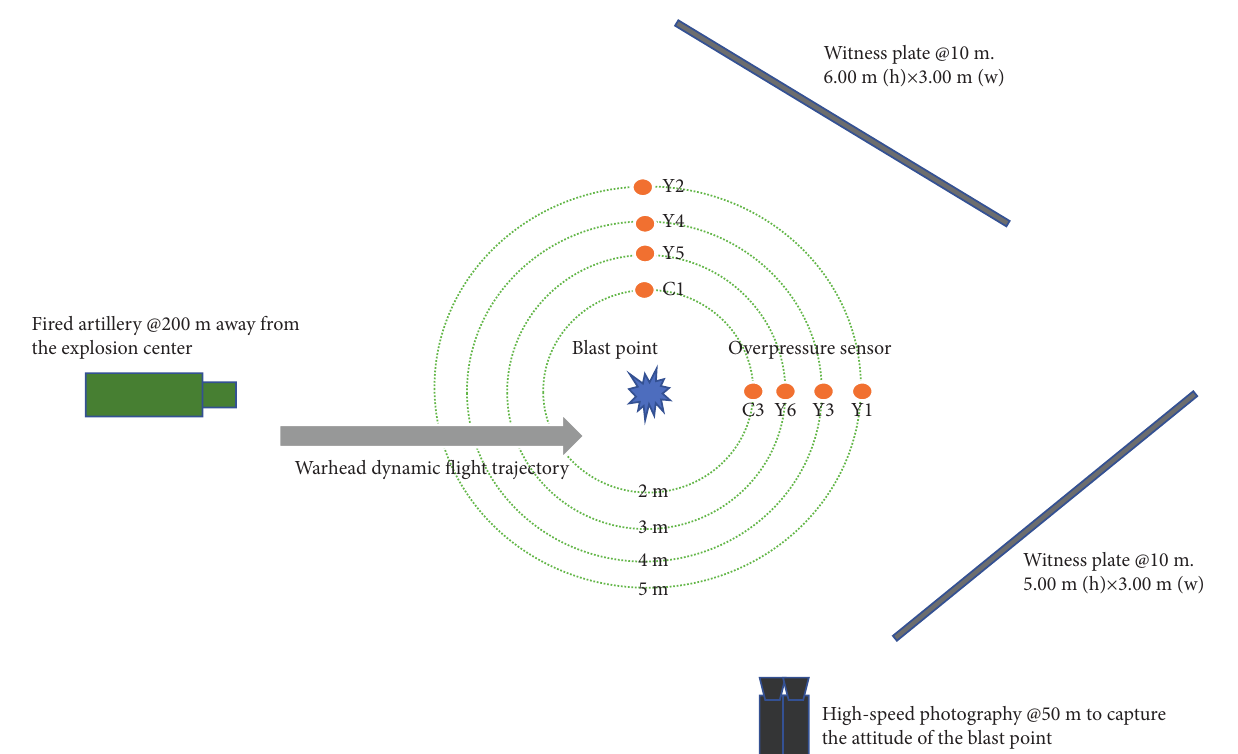
Figure 1: Schematic diagram of rectangular target layout.